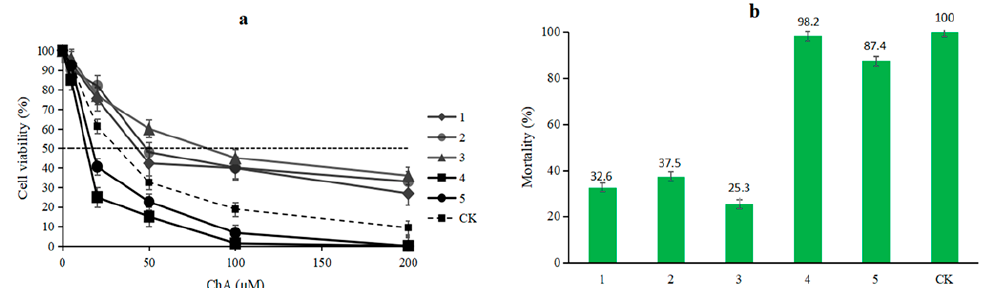
Figure3. Bioactiveassayofcompounds 1 – 5: (a) CellviabilityinhibitionofHepG2cell, CK:camptothecin; (b) mortality rates to Artemia salina , CK: actinomycin Figure 3. Bioactive assay of compounds 1 – 5: (a) Cell viability inhibition of HepG2 cell, CK: camptothecin; (b) mortality rates to Artemia salina , CK: actinomycin D.